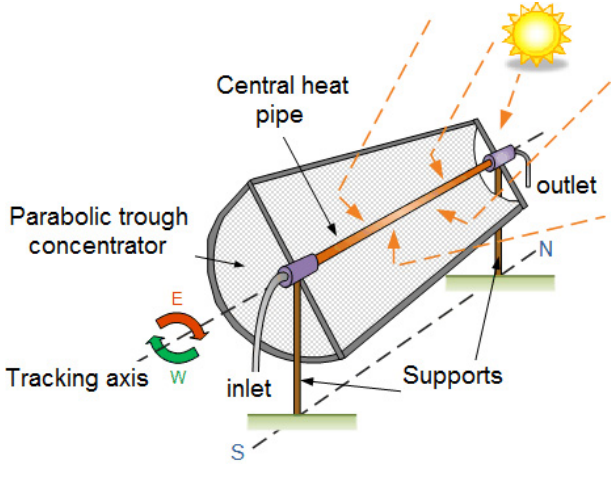
Figure 2. Flow diagram of the proposed system